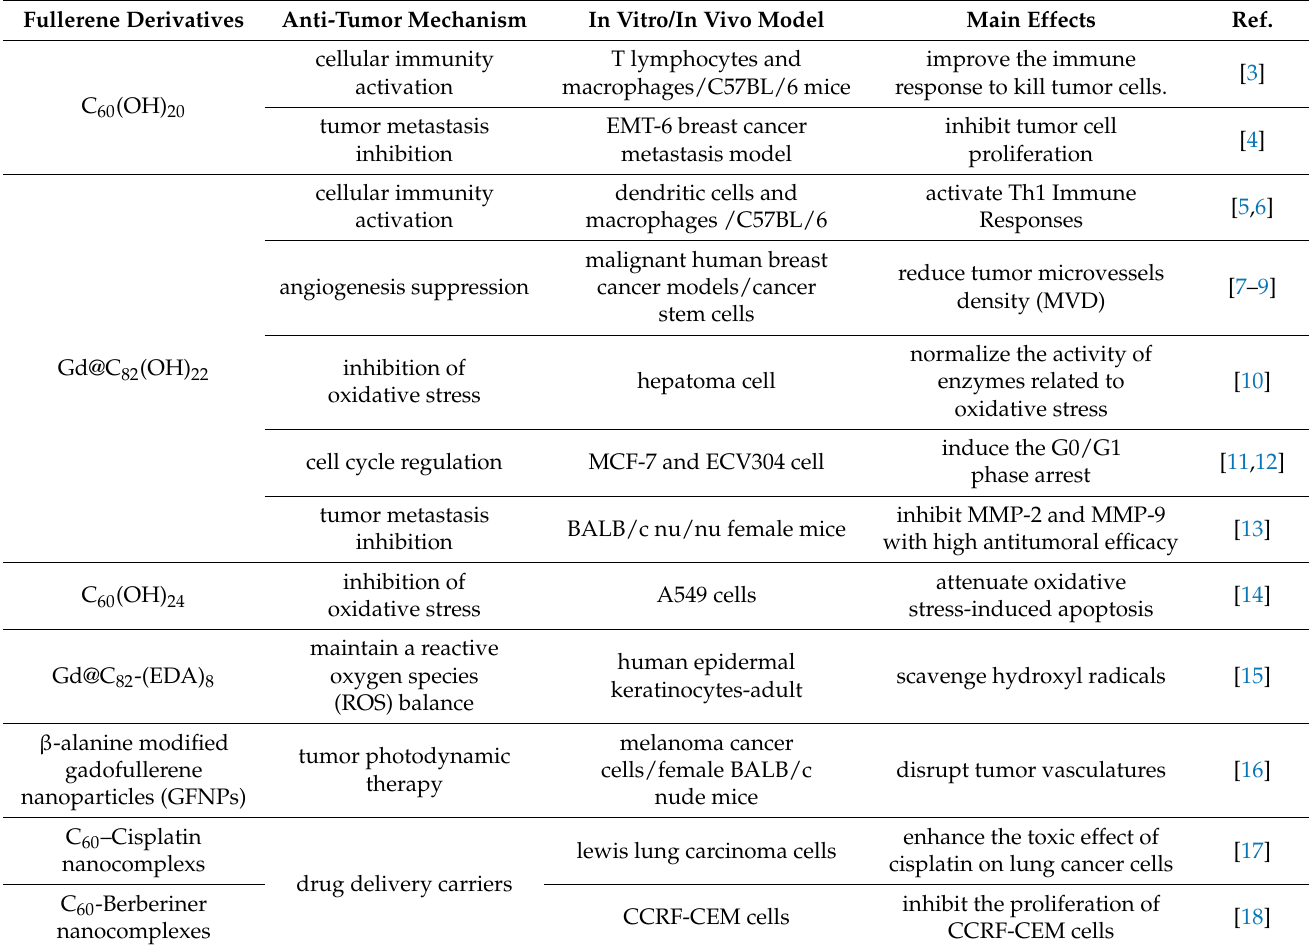
Table 1. Fullerene derivatives with anti-tumor